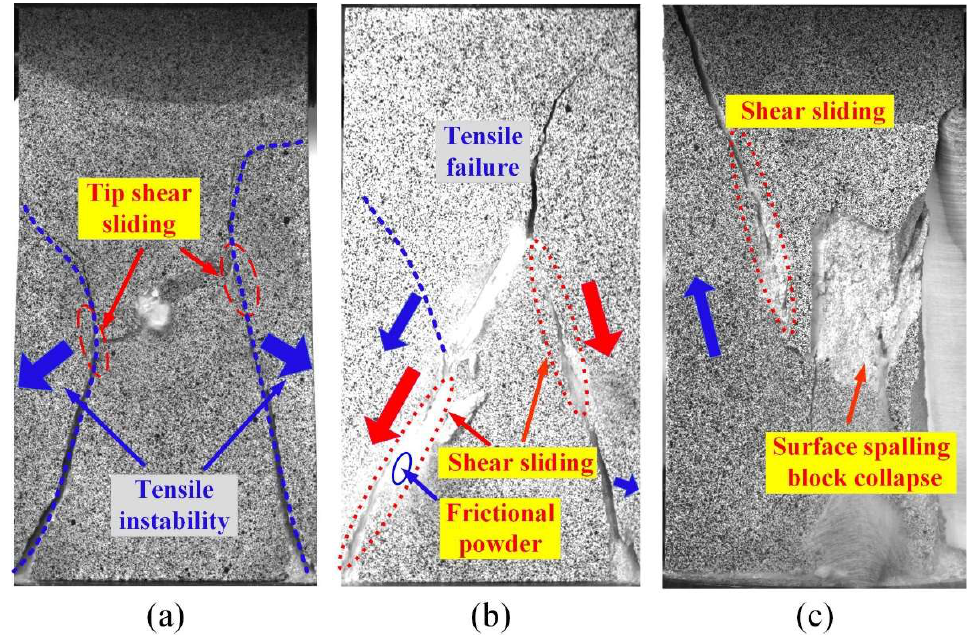
Figure 10. Three failure modes in unanchored samples: ( a ) mode I; ( b ) mode II; ( c ) mode